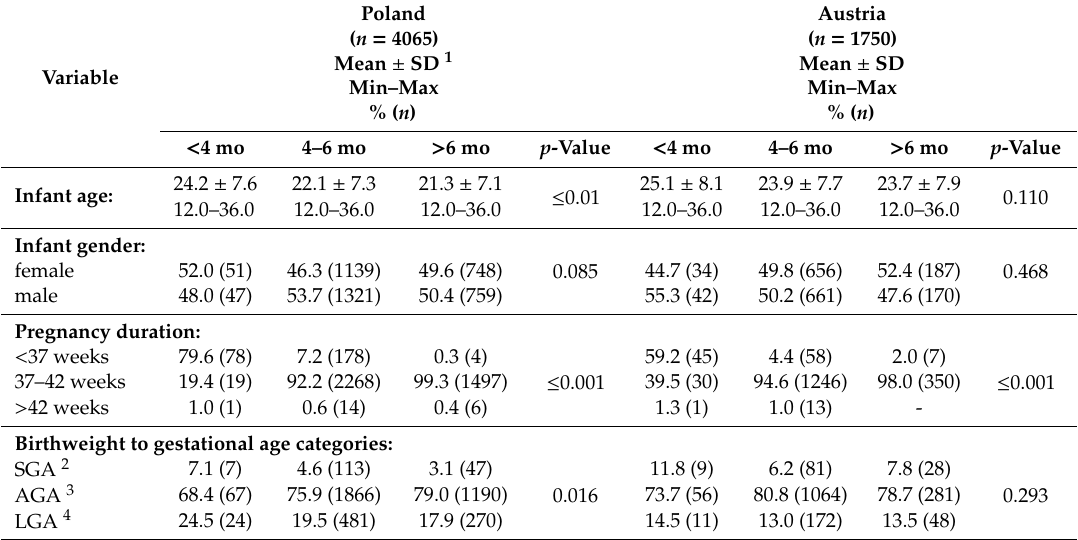
Table 2. Children’s characteristics including birth parameters and feeding methods according to the age of introducing complementary feeding into infant